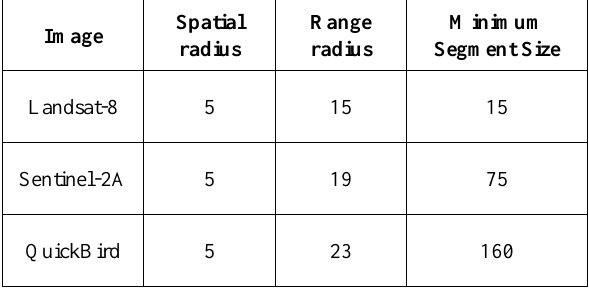
Table 1. Optimal parameters values for MeanShift segmentation Figure 5. Object-Based Image Analysis methodological framework